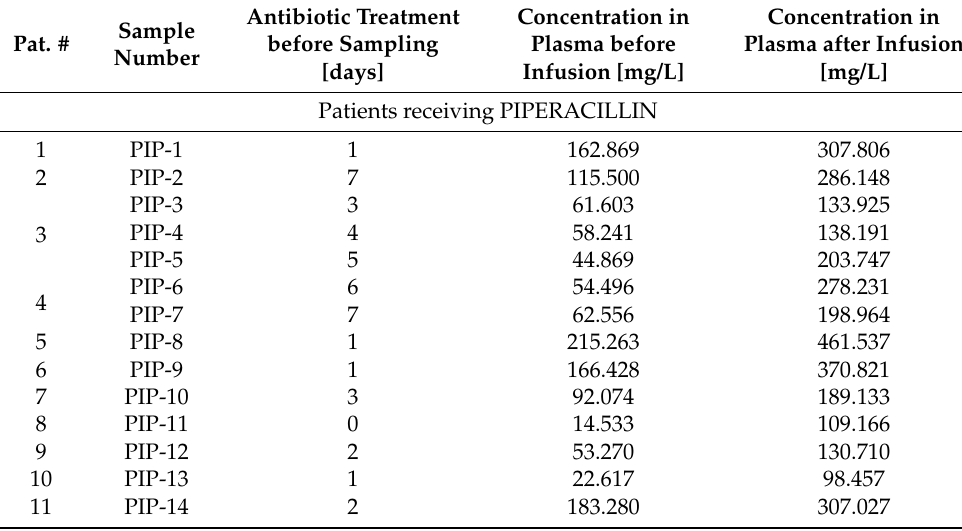
Table 8. Plasma concentration of unbound piperacillin and unbound imipenem before and after drug administration according to the protocol described in the text. The value “0” (zero) in antibi- otic treatment duration indicates that the day of sample collection is the first day of receiving the respective